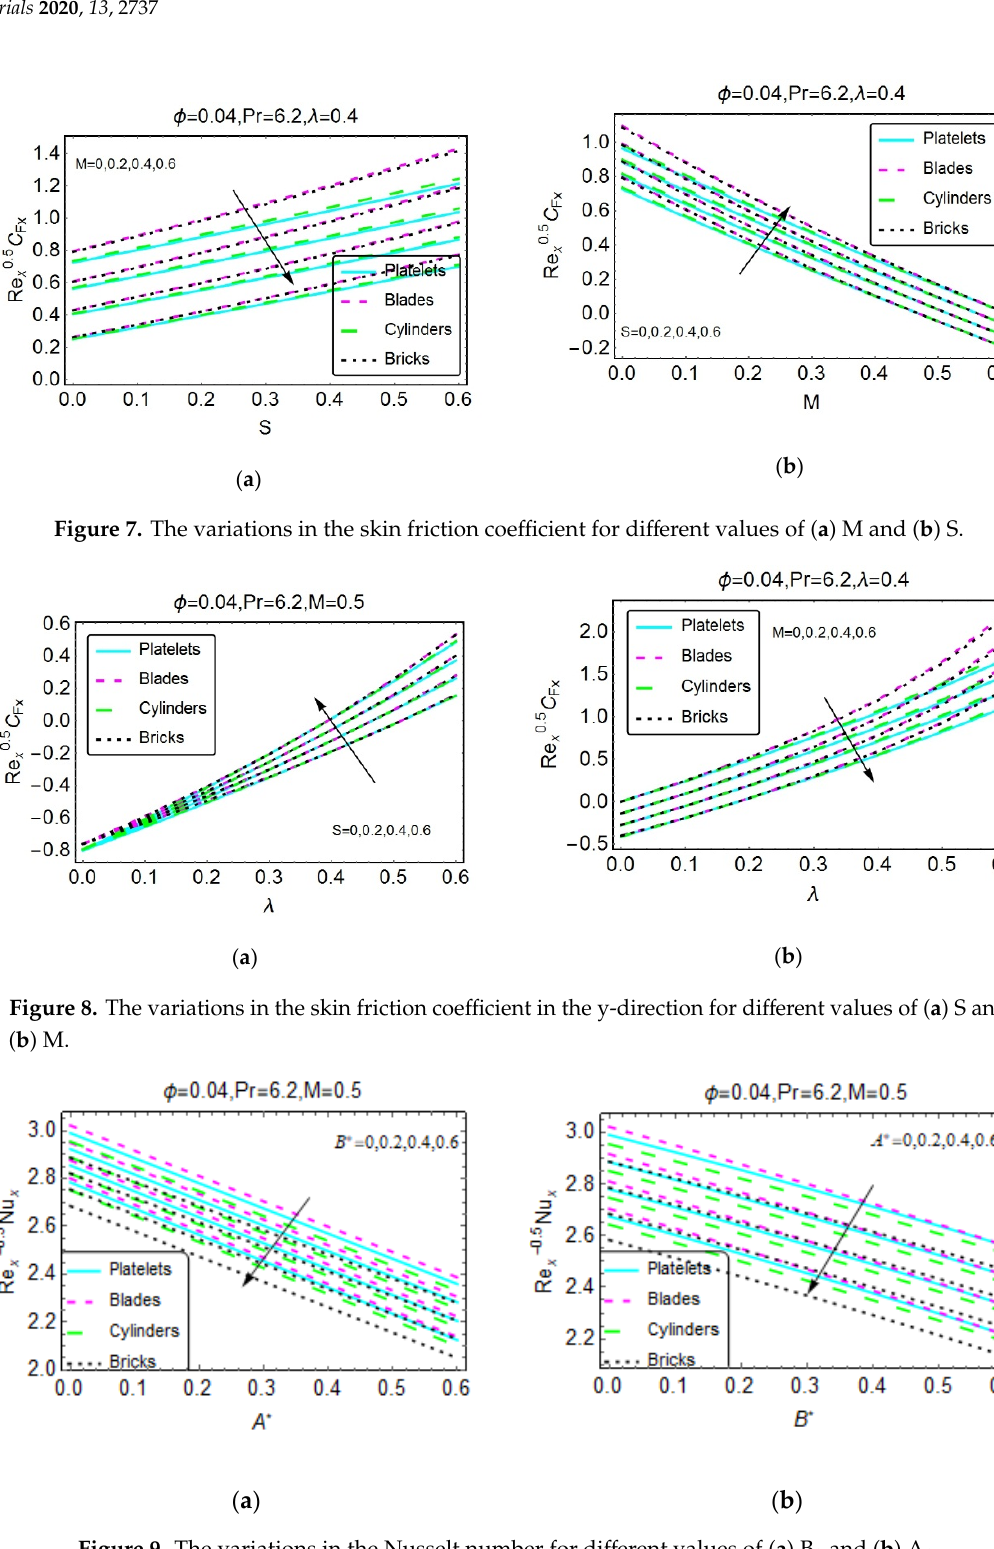
( b ) Figure 10. Variations in the Nusselt number for different values of ( a ) S and ( b ) M . Figure 11. Variations in the Nusselt number for different values of S. 4. Validation of the Analysis